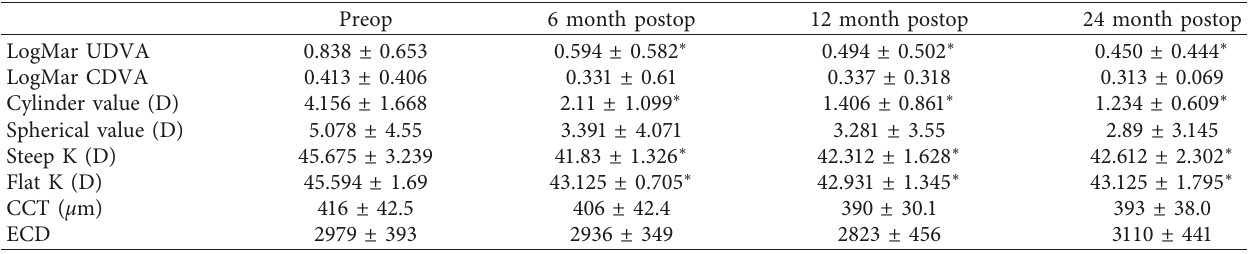
Table 1: Preoperative and postoperative patient data for visual acuity, refraction, keratometry, CCT, and endothelial cell density. Preop 6 month postop LogMar